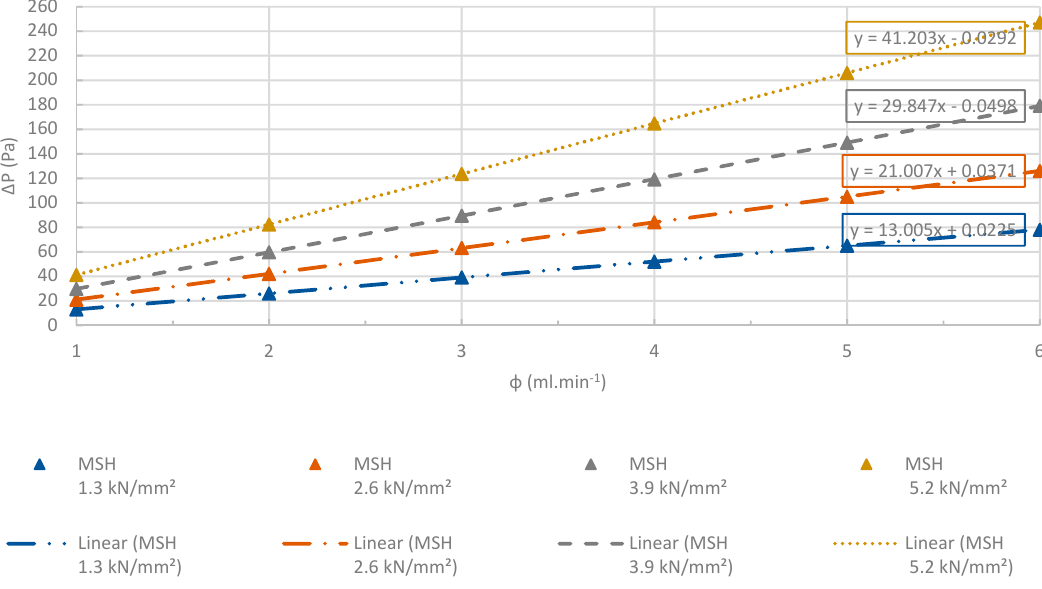
Figure 26. Changes at differential pressures of the MSH pellets with increasing flow rates. R 2 > 0.99. The accuracy of the pressure measurements was less than 0.1%.